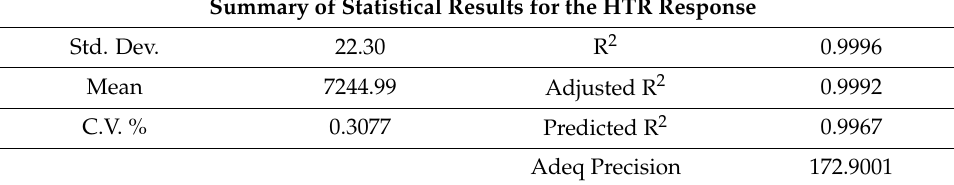
Table 7. Summary of statistical results for the HTR